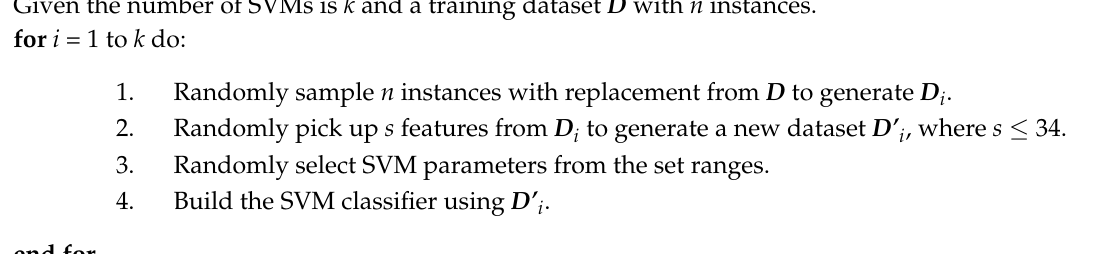
Algorithm 1: SVM-based Ensemble